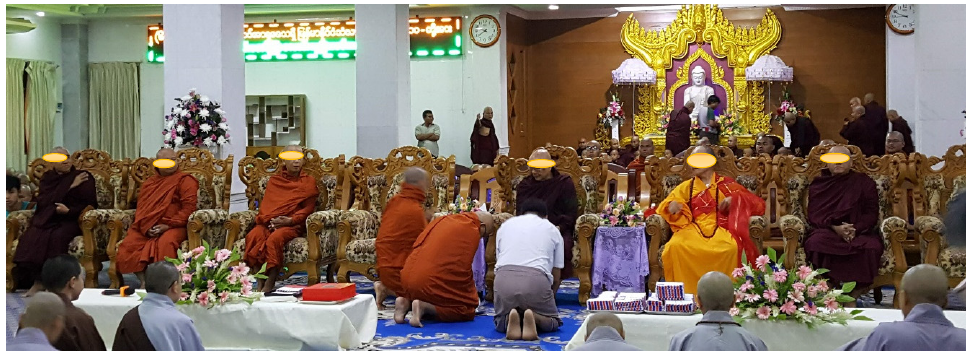
Figure 6. Monks and a layman talk to Sayadaw U Tiloka Bhivamsa and pay homage to him before an event (Source: